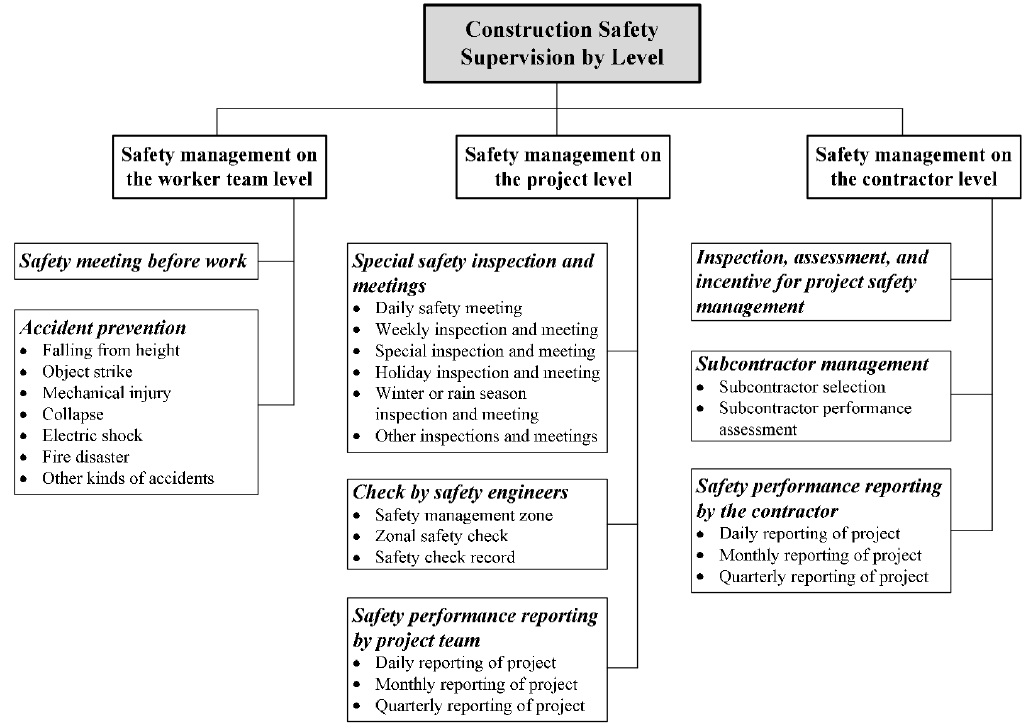
Figure 6. Structure of the safety supervision